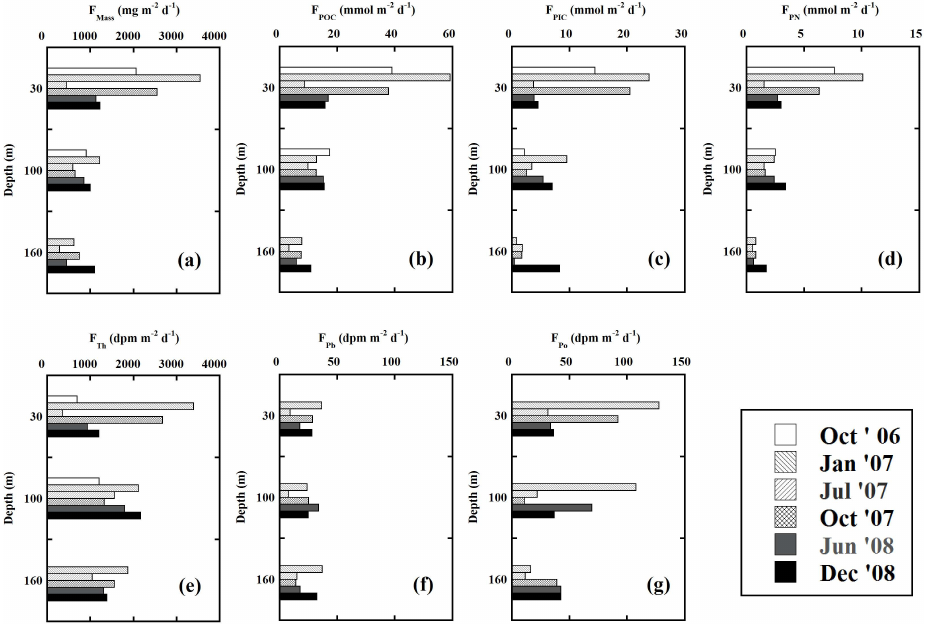
Fig. 5. Fluxes of (a) total mass ( F mass ), (b) particulate organic carbon ( F POC ), (c) particulate inorganic carbon ( F PIC ), (d) particulate